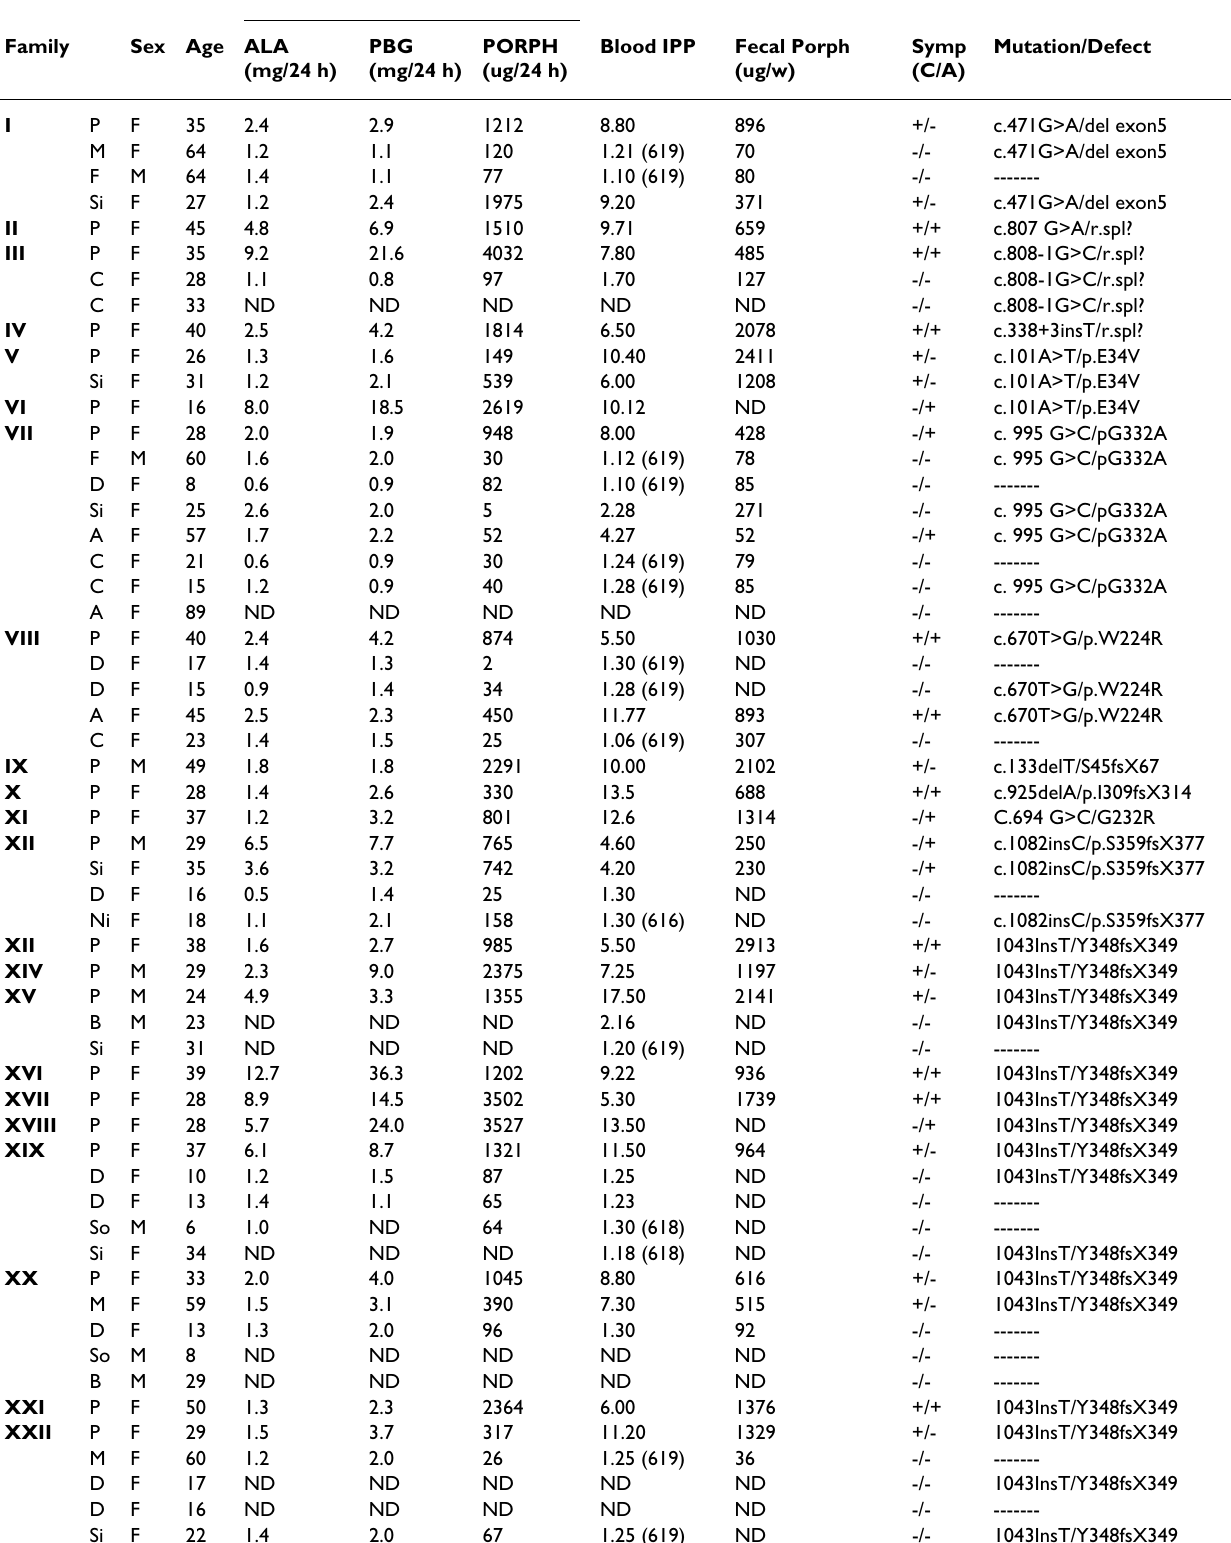
Table 1: VP Argentinean families: biochemical and molecular data Urine Family Sex Age ALA (mg/24